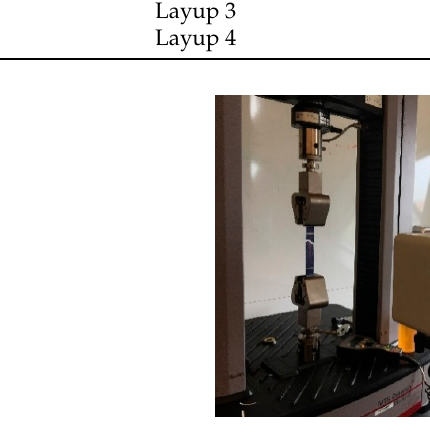
Figure 9. Tensile testing of the printed specimen. Table 7. Modulus of elasticity of the laminate from classical laminate theory. E xx , MPa